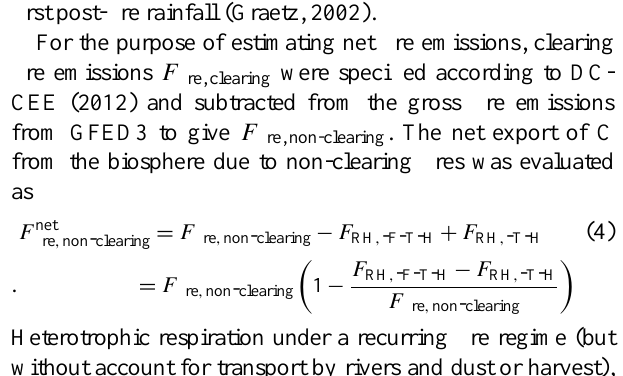
landscapes are resilient, with regrowth commencing after the first post-fire rainfall (Graetz,